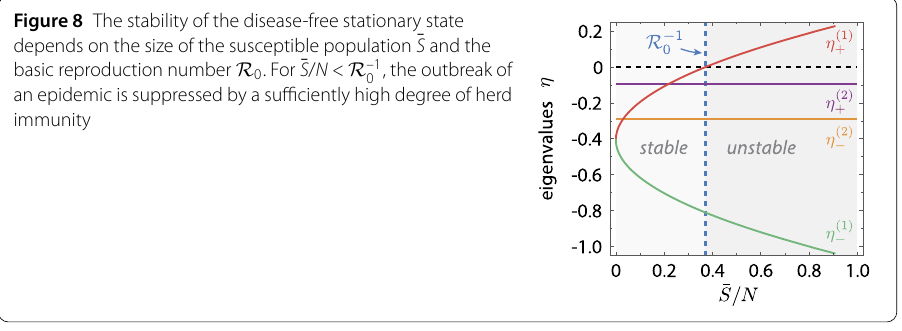
Figure 8 The stability of the disease-free stationary state depends on the size of the susceptible population ¯ S and the basic reproduction number R 0 . For ¯ S / N < R –1 0 , the outbreak of an epidemic is suppressed by a sufficiently high degree of herd